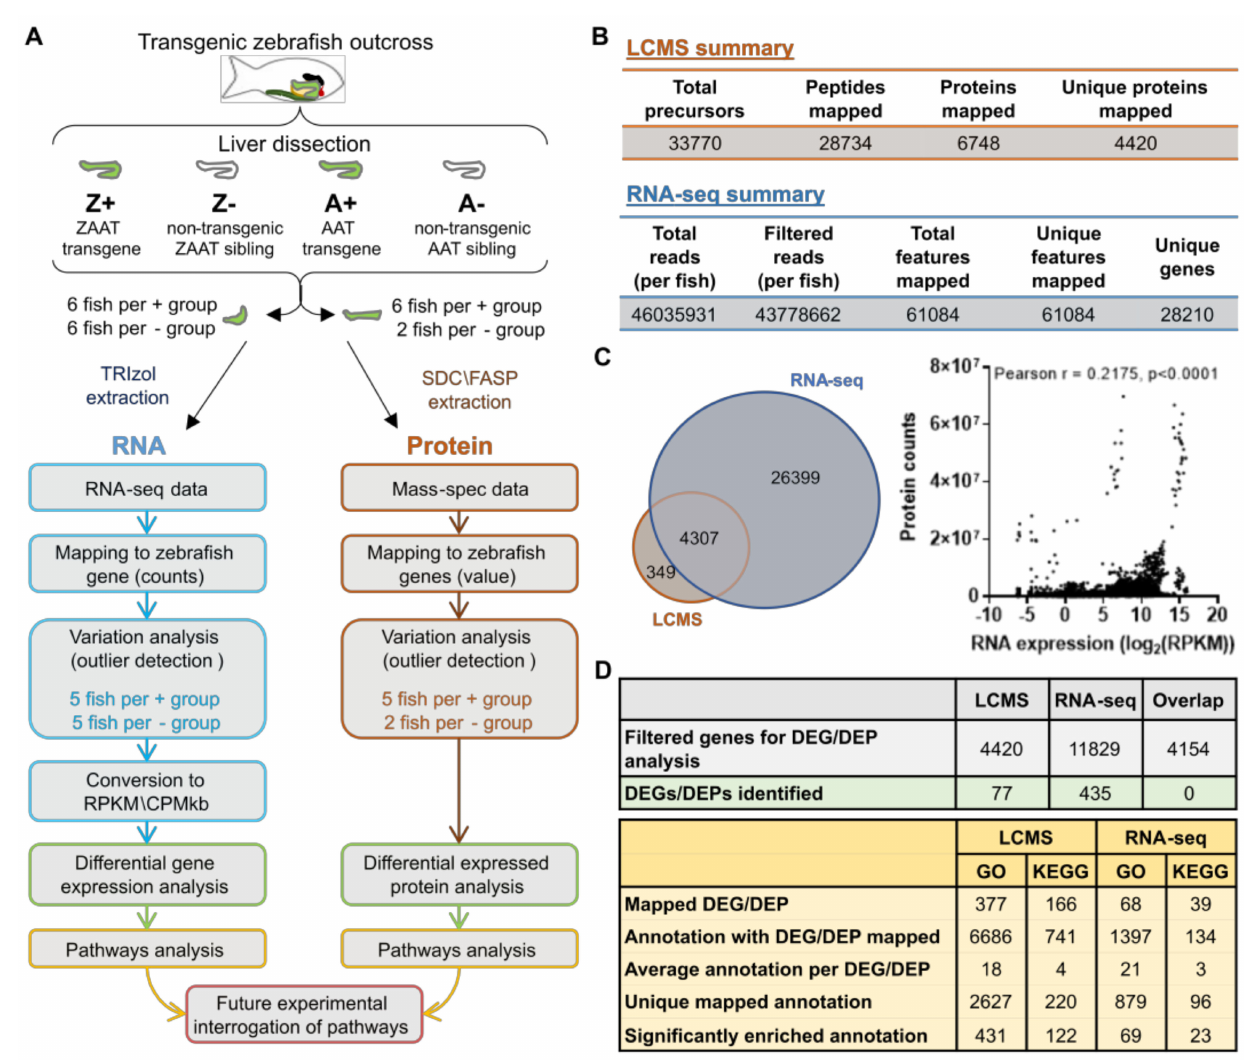
Figure 1. Overview of the global transcriptomic/proteomic approach to identify dysregulated path- ways in ZAAT-expressing zebrafish livers. ( A ) Six fish in each genotype group were analysed, with protein and RNA samples extracted from each liver sample. Fish identified as outliers were excluded from subsequent analysis (see Supplementary Figure S2). ( B ) Summary statistics of LC-MS/MS and RNA-seq data aligned to the reference library or genome. ( C ) Comparison of libraries generated from RNA-seq and LC-MS/MS data (left panel). Correlation analysis of transcriptomic and proteomic expression profiles (right panel). Each point represents protein (counts) and RNA (log 2 CPM/kb) expression data from one gene in one fish. (Pearson r, r = 0.2157, p < 0.0001). ( D ) Summary statistics of differential expression analysis (top panel) and pathway enrichment analysis (bottom